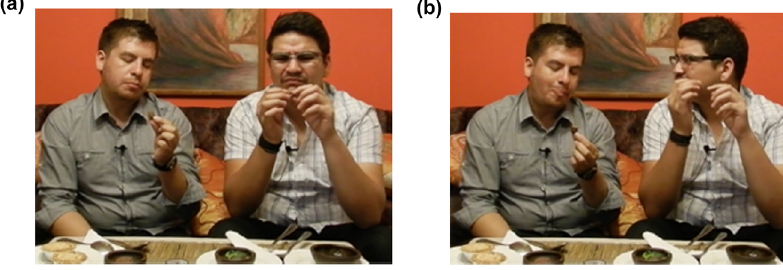
Figure 4: Screenshots ( a and b ) illustrating the embodied behaviour at line